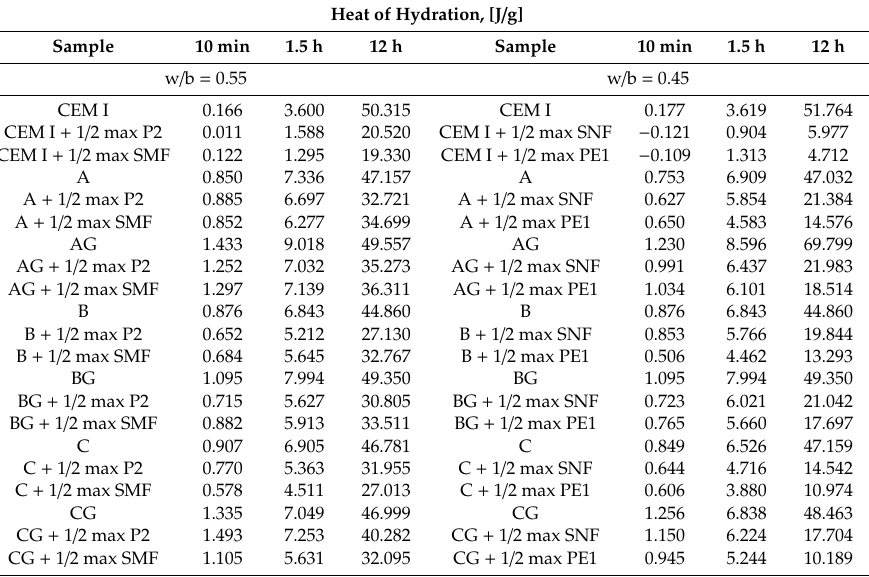
Table 8. Heat of hydration of cement and CFA paste with P2 and SMF, SNF and PE1 [J / g] during 12 h.